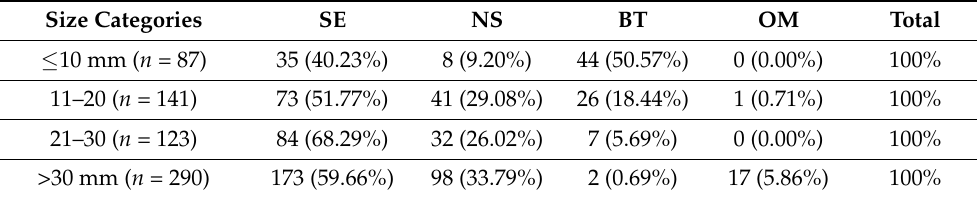
Table 5. Frequencies of histologic subgroups in four tumour size categories.